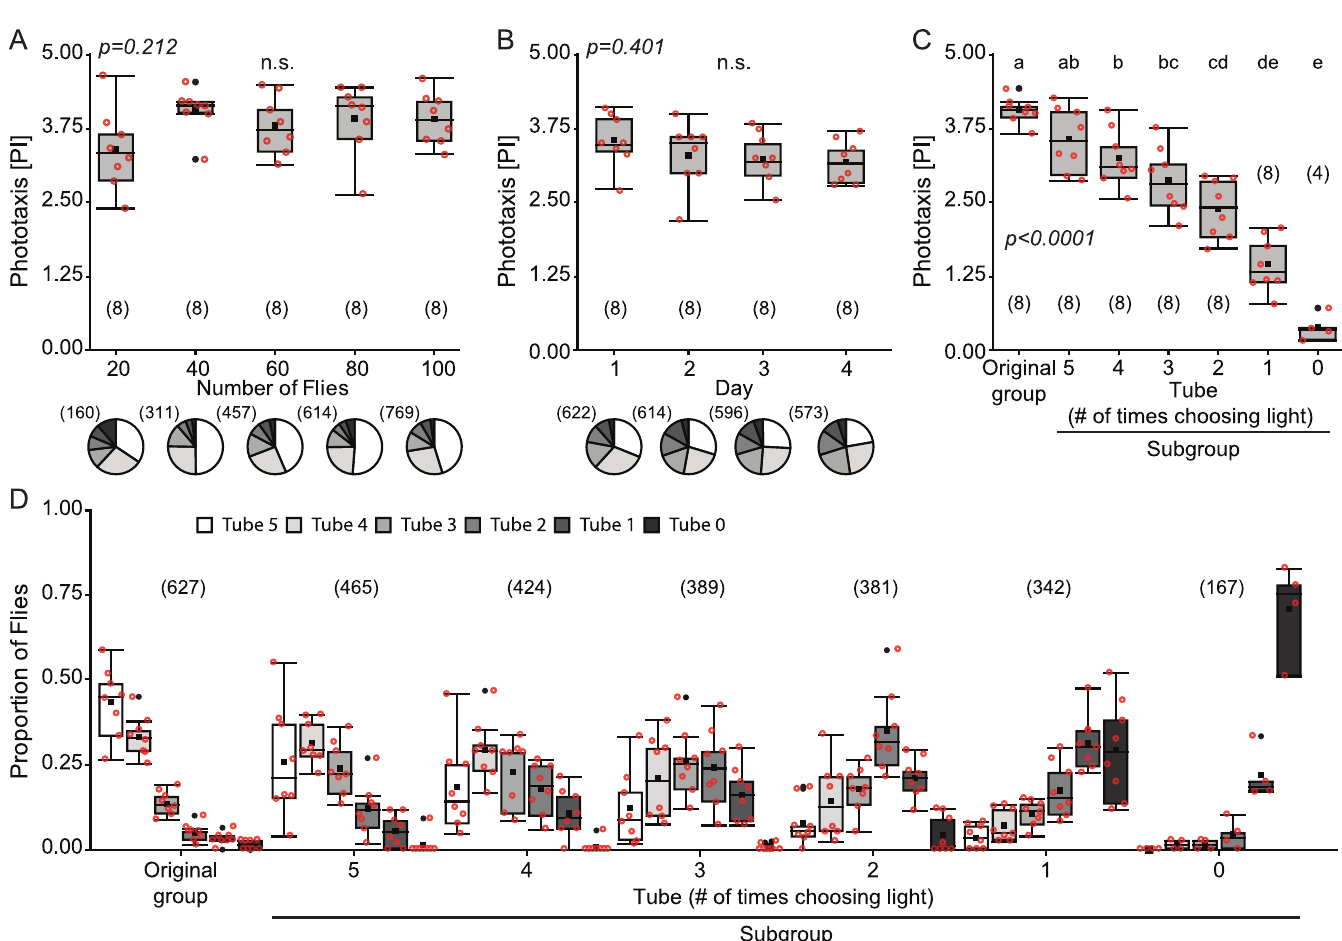
Fig 3. Repeated testing reveals individuality of flies also in group tests. (A) Groups of 20, 40, 60, 80 or 100 flies were tested for phototaxis in the CPP. Upper: Box plots of phototaxis index (PI). Lower: Pie charts illustrate the distribution of all tested flies in each tube. (B) Repeated phototaxis tests of flies in groups of 80 individuals on four consecutive days. (C) Phototaxis of subgroups generated by a single prior session CPP (Original). p < 0.005: different letters indicate significant differences. (D) Proportion of flies in each tube in the experiment depicted in (C). Box plots denote quantiles 0.05, 0.25, 0.75 and 0.95, median, mean (black square), and outliers (black dots). Individual data points are shown in red circles. n.s: not significant. Numbers in brackets indicate sample size.